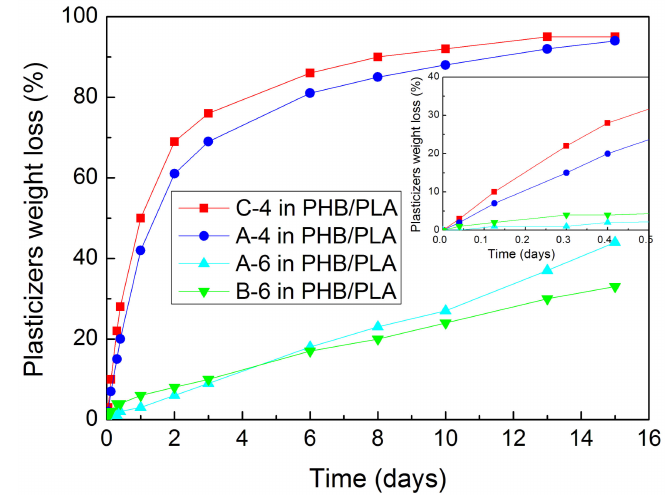
Figure 7. Plasticizers weight loss (%) from PHB/PLA/plasticizer blends after up to 15 days of exposition to 110 ◦ C in the drying